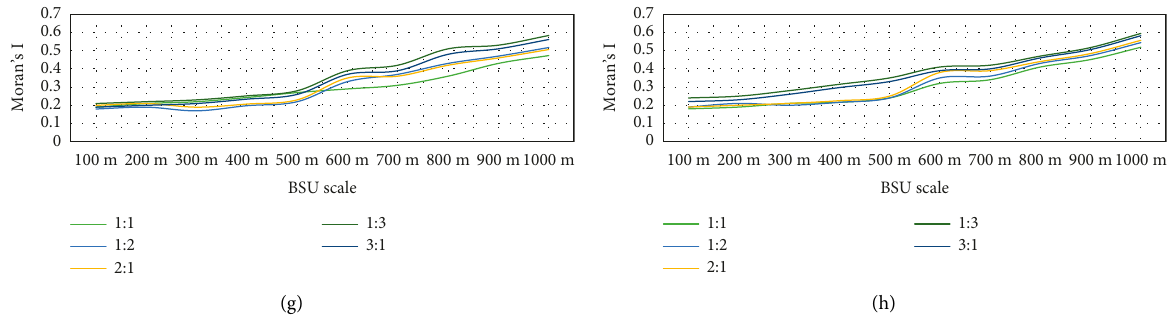
Figure 11: Moran’s I of variables. (a) Moran’s I of HH I. (b) Moran’s I of Intersection density. (c) Moran’s I of bus station density. (d) Moran’s I of population density. (e) Moran’s I of distance to CBD. (f) Moran’s I of traffic safe. (g) Moran’s I of traffic comfortable. (h) Moran’s I of traffic efficiency.